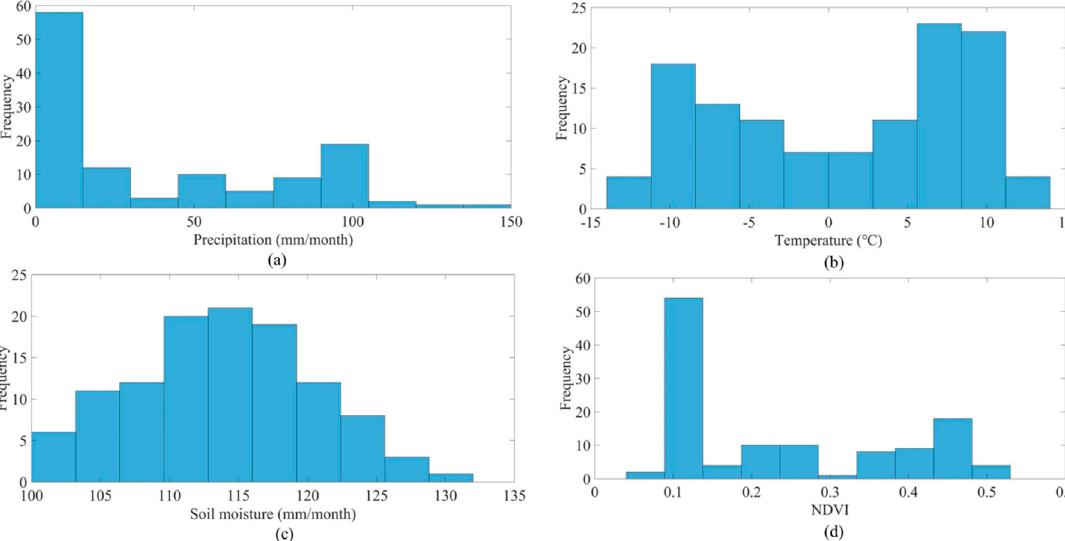
Figure 7. Frequency distribution of monthly remote sensing data used in this study across the TRHR ( a ) Precipitation, ( b ) Temperature, ( c ) Soil moisture and ( d ) NDVI.